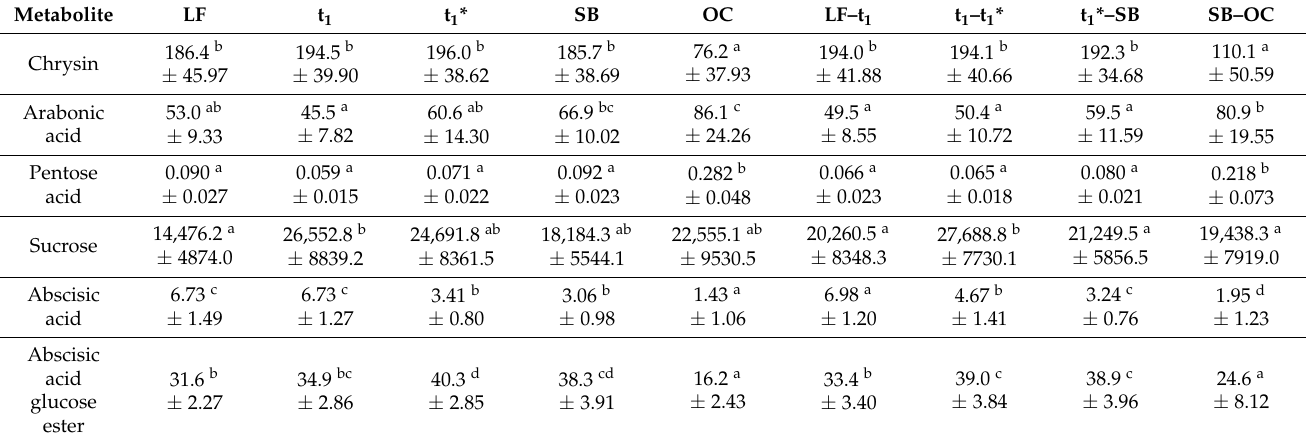
Table 1. Average content (mean of nine years ± standard deviation) of six selected metabolites in µ g/(g DW) at five phenological stages ‘total leaf fall’ (LF), endodormancy release (t of ontogenetic development (t 1 *), ‘swollen bud’ (SB), ‘open cluster’ (OC) as well as during four phenological phases: endo- (LF–t 1 ), ecodormancy phase (t 1 –t 1 *) and ontogenetic development (t 1 *– SB; SB–OC). Different letters indicate significant differences between the metabolite content within stages and phases (ANOVA, Tukey-HSD test, p ≤ 0.05).